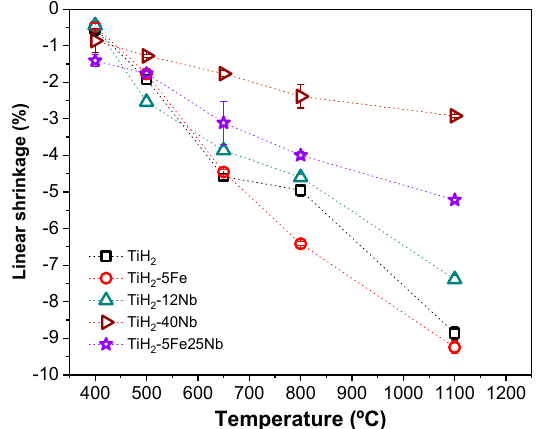
Figure 6. Linear shrinkage for samples heated under VAC conditions at different temperatures.